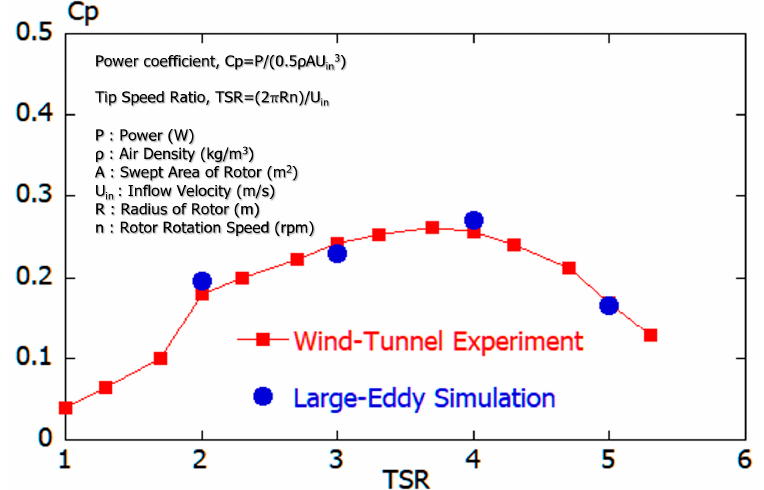
Figure 5. Relationship between tip-speed ratio (TSR; horizontal axis) and power coefficient Cp (vertical axis) of the wind-turbine scale model tested in the wind-tunnel experiment. Here, both the results of the wind-tunnel experiment and the large-eddy simulation show the time-averaged value.